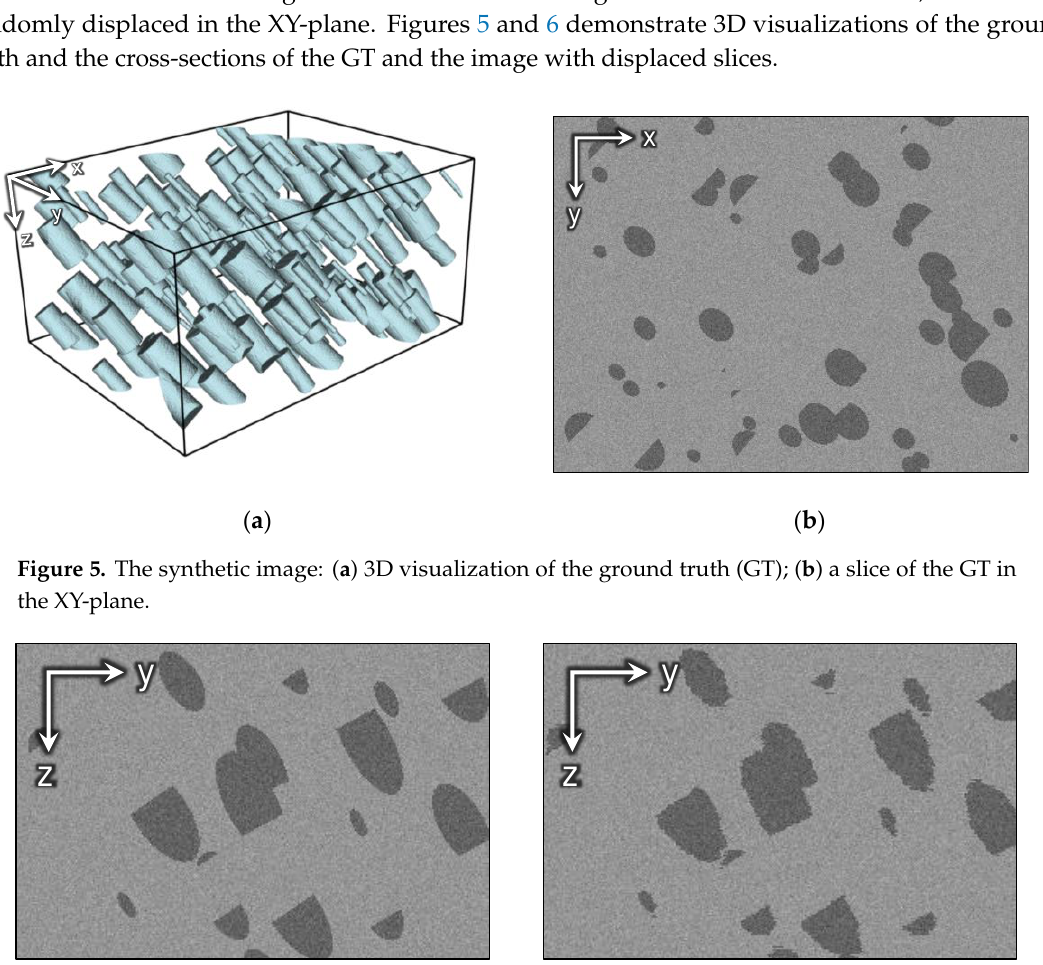
Figure 4. Image B: ( a ) a slice in the XY-plane including unchanged fragment outlined by the dashed line; ( b ) 3D visualization of the cropped region and enlarged fragment demonstrating misalignment